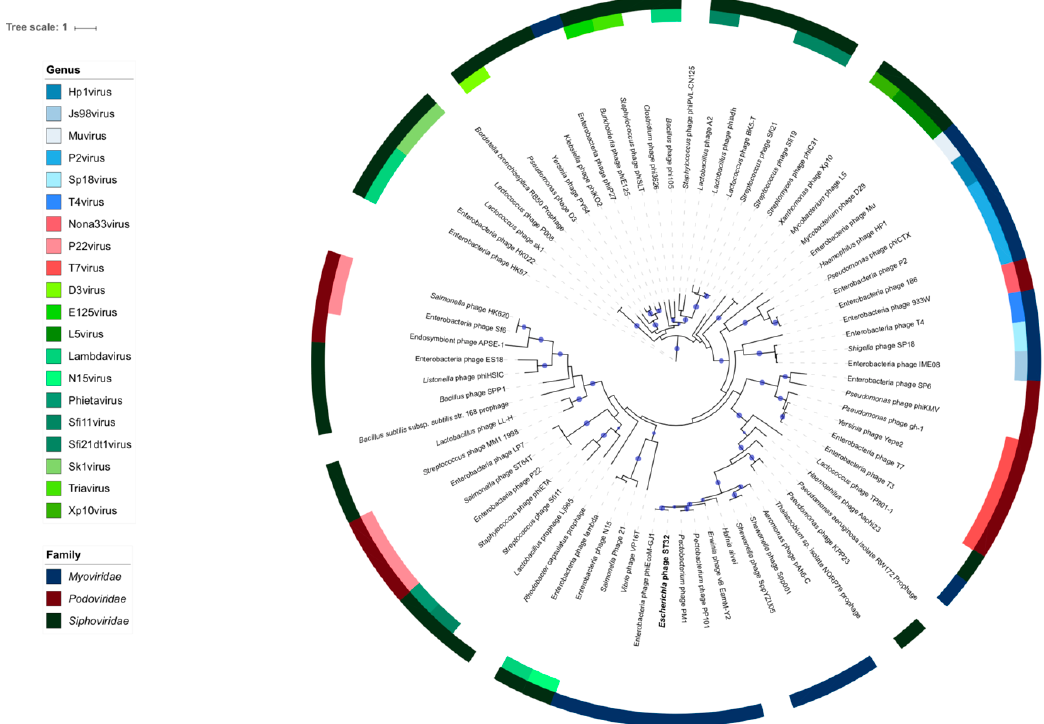
Figure 3. Phylogenetic tree based on the amino acid sequences of the large terminase subunit (ORF51) of phage ST32 and the phages available in databases sharing sequence identity. The corresponding phage protein sequences were retrieved from GenBank (https://www.ncbi.nlm.nih.gov/). The colors in the internal and external circular layers categorize phages, genera, and families, respectively. When the genera or the family of a phage is not indicated, it means that it was not available in the database or in the associated publication. Branches with branch support values greater than 90% are marked with a blue dot. The size of the dot is directly proportional to the branch support value.